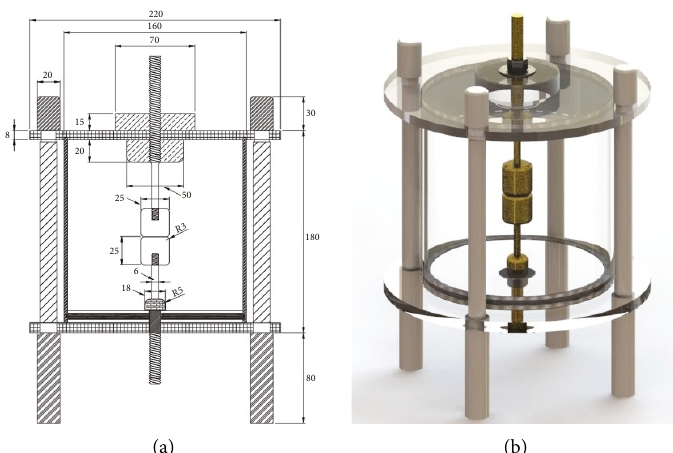
Figure 4: The parameters and design of the test vessel for measuring the voltage strengths. (a) Details of test vessel design (mm). (b) 3D Test vessel